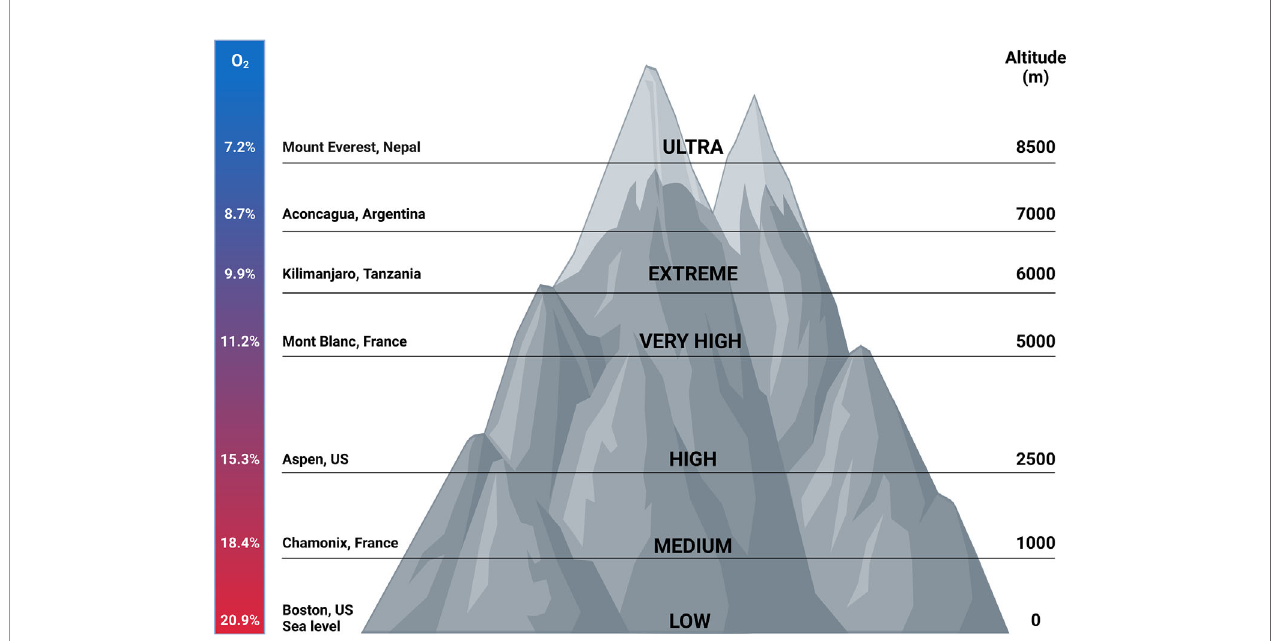
FIGURE 5 | Correlation between altitude and oxygen concentrations. Millions of people live permanently at high altitude. Also travelling to regions of high altitudes has gained interest throughout the years. In this fi gure, oxygen concentrations correlated with certain altitudes are depicted. In addition, the grade of hypoxia present at certain places worldwide are shown. Figures created with